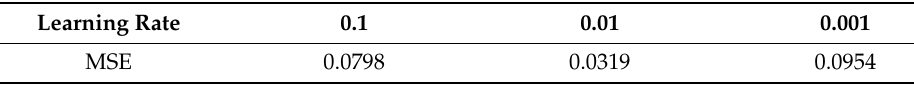
Table 7. Results with different learning rates.